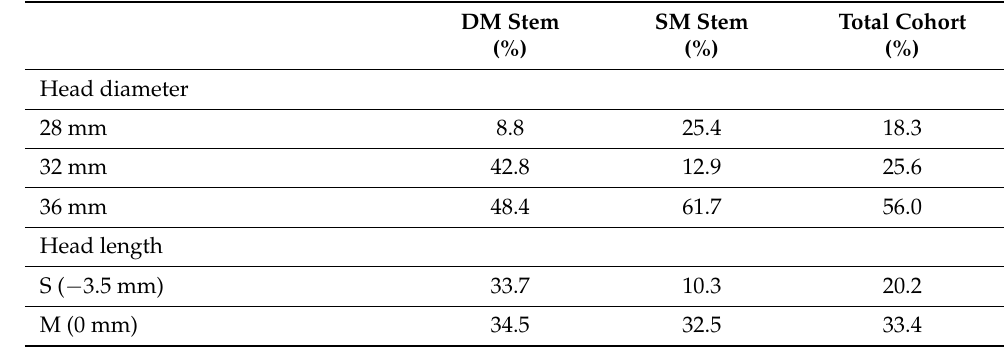
Table 3. Implant characteristics of the femoral stems, heads and modular necks used.